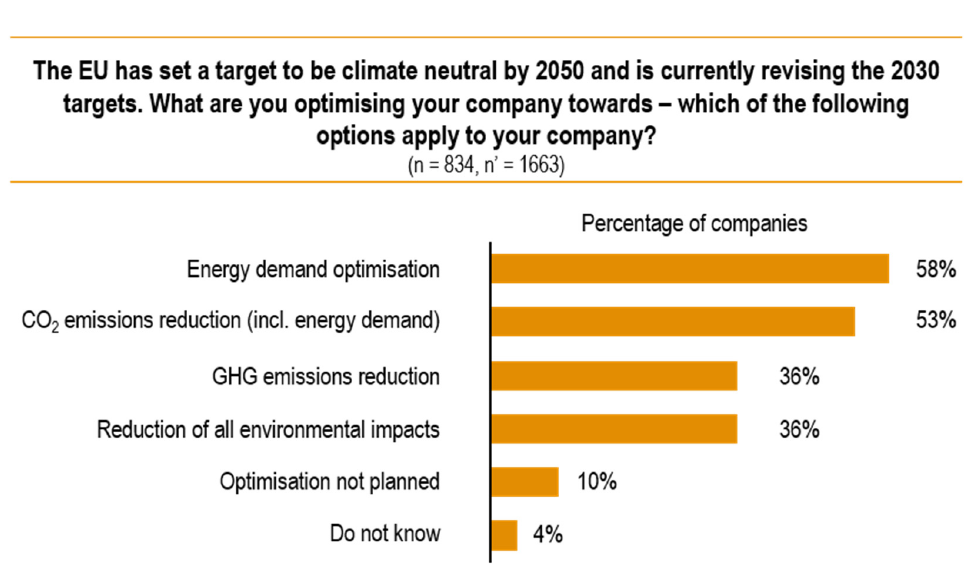
Figure 2. Target dimensions companies optimise towards [41].